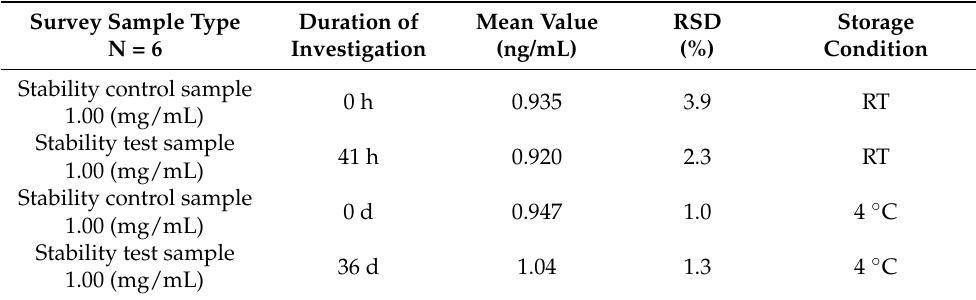
Table 5. Evaluation results of the stability of the analytical solution during short-term placement at room temperature.